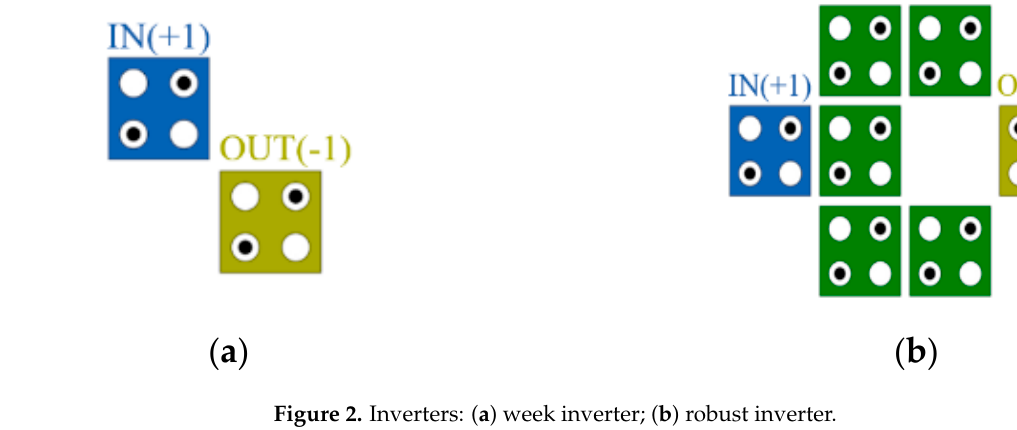
Figure 2. Inverters: ( a ) week inverter; ( b ) robust inverter.